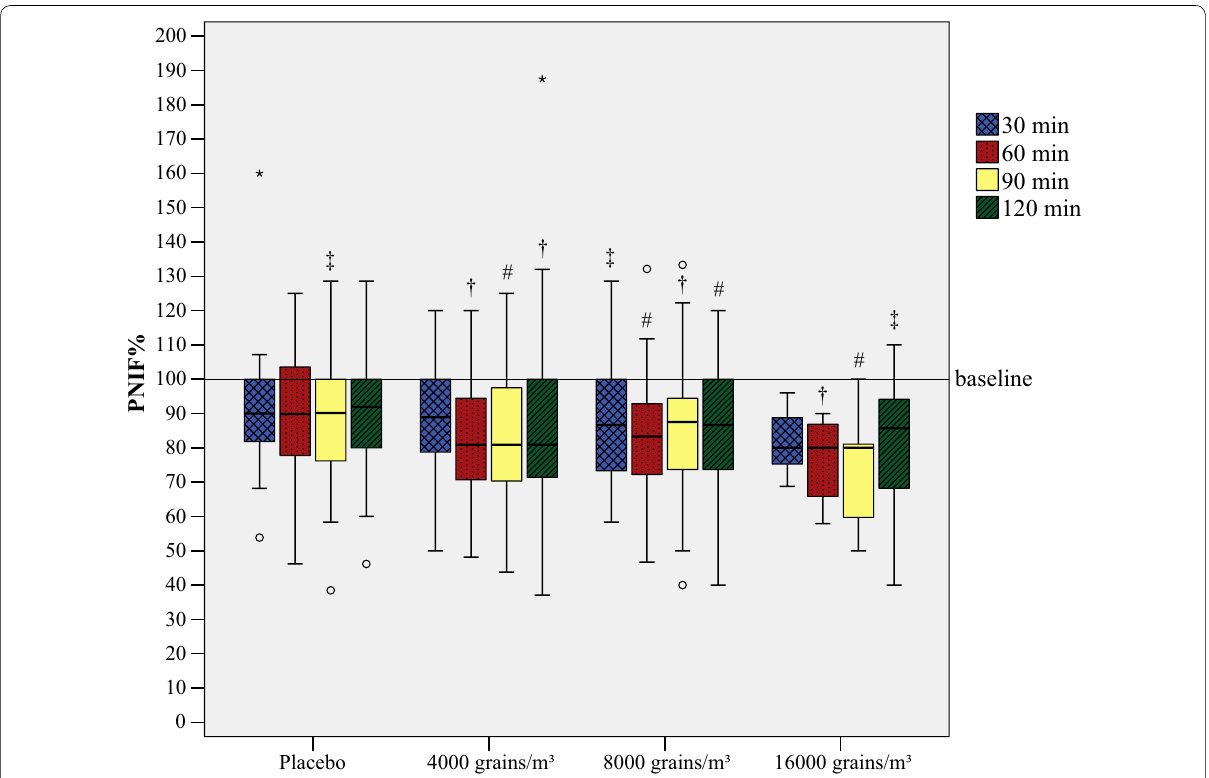
Fig. 2 Reduction of PNIF during exposure with birch pollen in the GA 2 LEN chamber. PNIF development during exposure with Betula pendula . A hash marks a reduction compared to baseline p < 0.001, a dagger a reduction compared to baseline p < 0.01 and a double dagger a reduction compared to baseline p < 0.05. Outliers are presented as degree sign, extreme outliers as asterisk. PNIF% is displayed as medians and